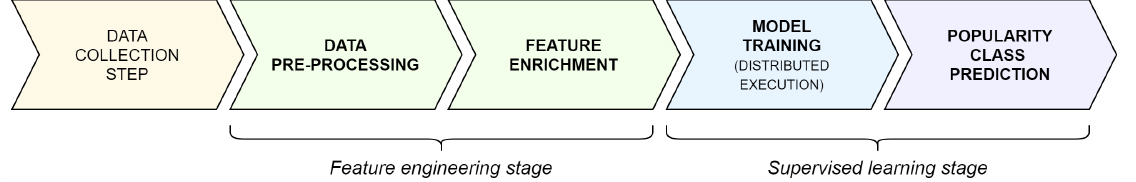
Figure 3. Overview of the proposed approach.